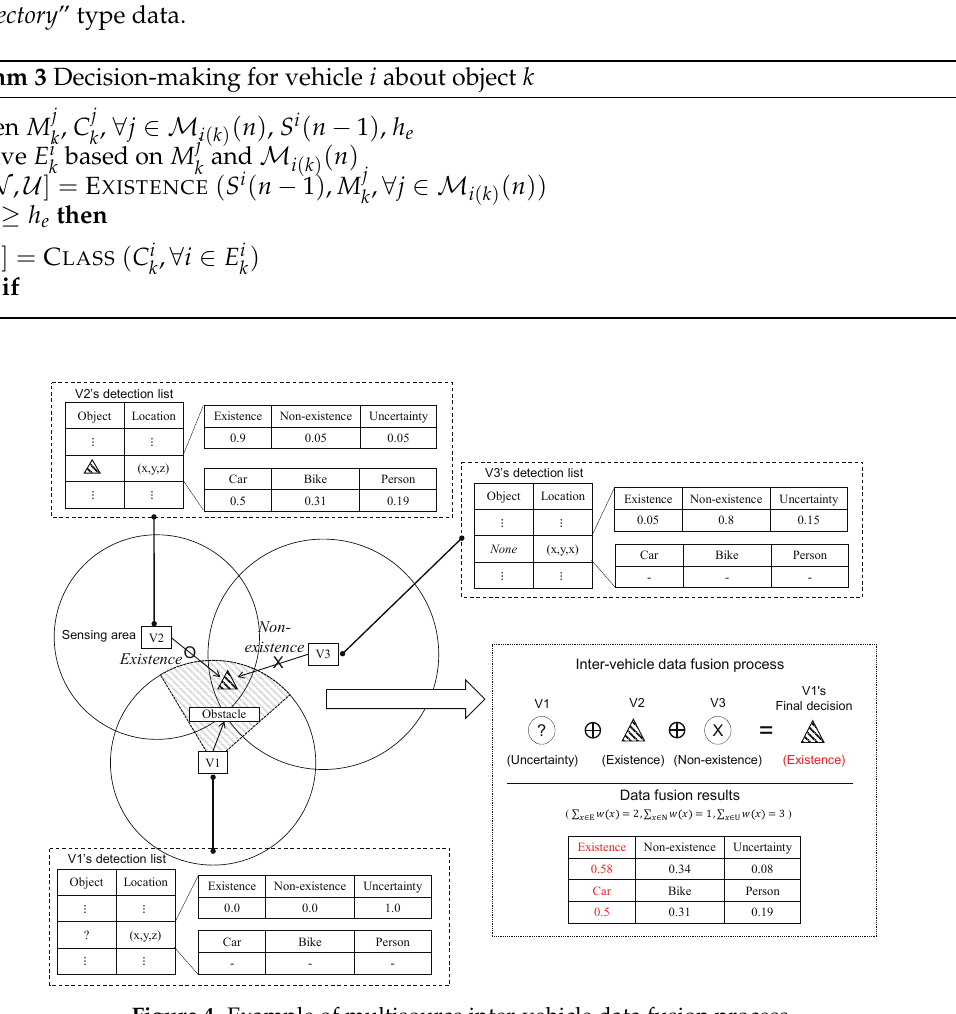
Figure 4. Example of multisource inter-vehicle data fusion